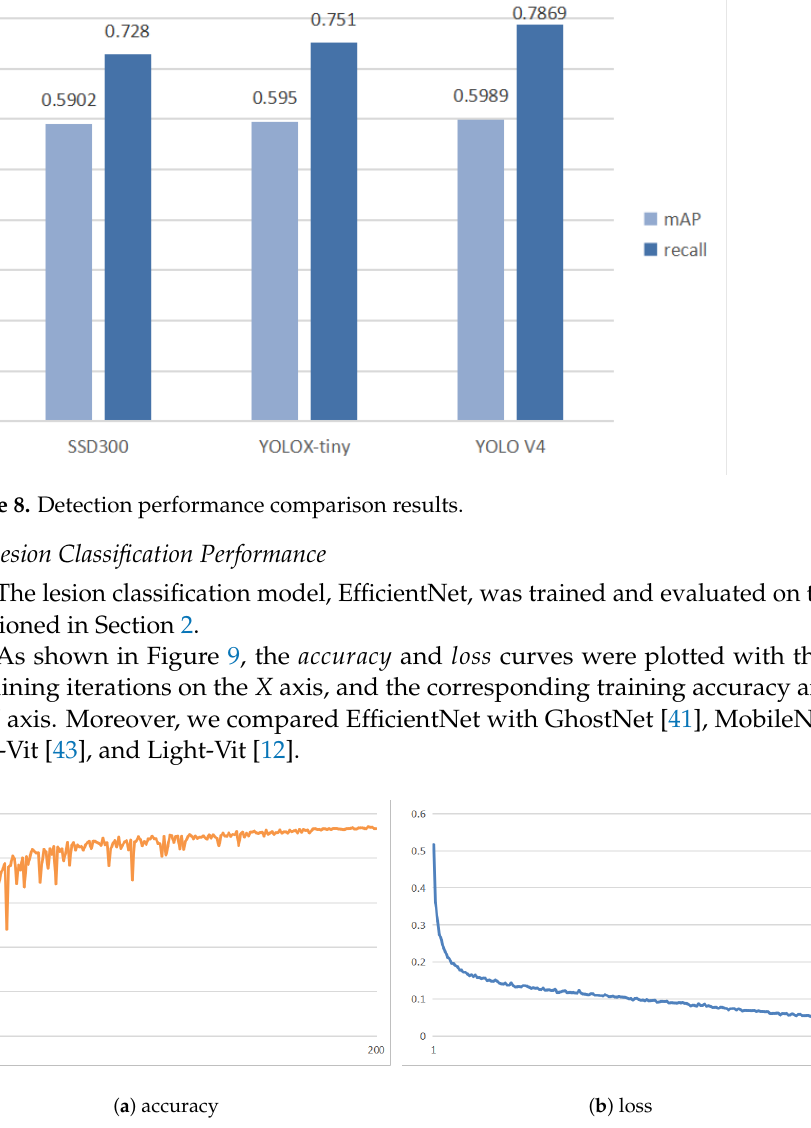
Figure 9. The training accuracy and loss curves of